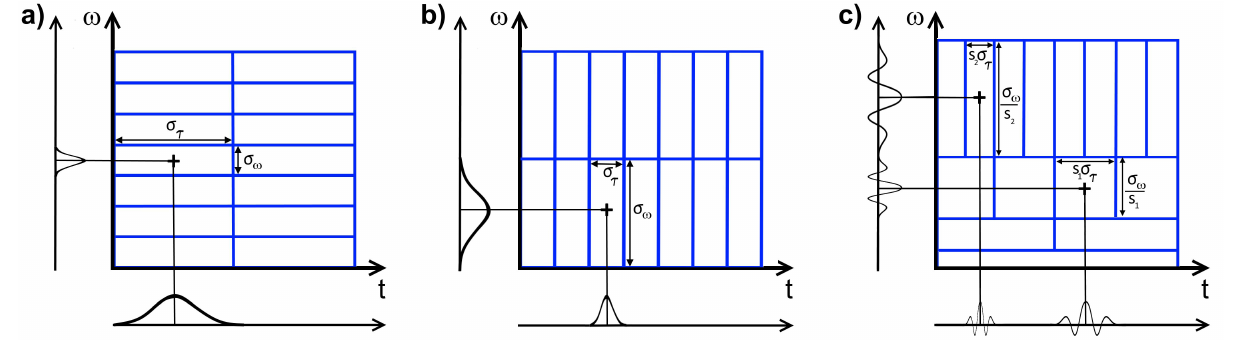
Figure 3. A few adjacent Heisenberg boxes of the STFT ( a , b ), and CWT ( c